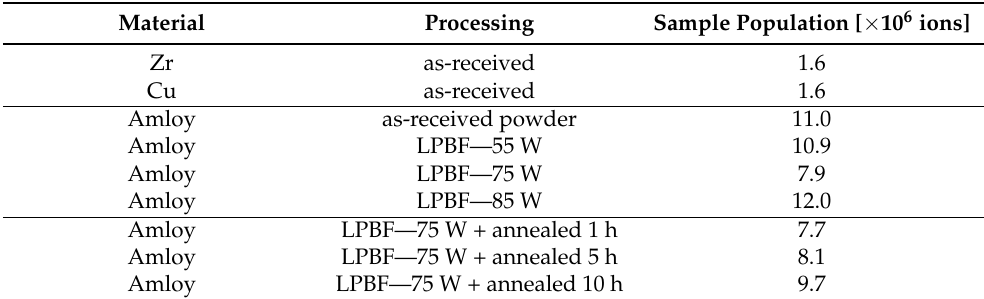
Table 2. Atom probe tomography measurements overview. Bulk Amloy samples were produced by LPBF with different laser power settings. An annealing temperature of 390 °C was used for the heat